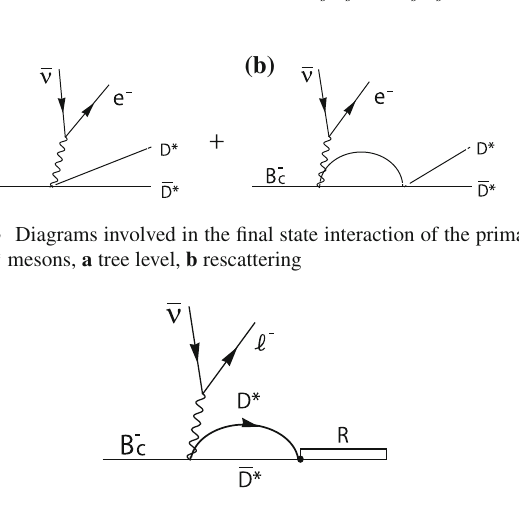
Fig. 4 Diagrams of the coalescence process which produce the reso- nances after